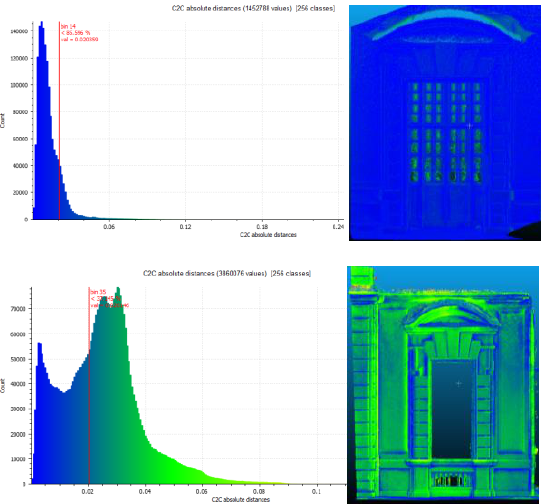
Figure 8. Comparison between TLS point cloud and Photoscan point cloud on two windows of the castle